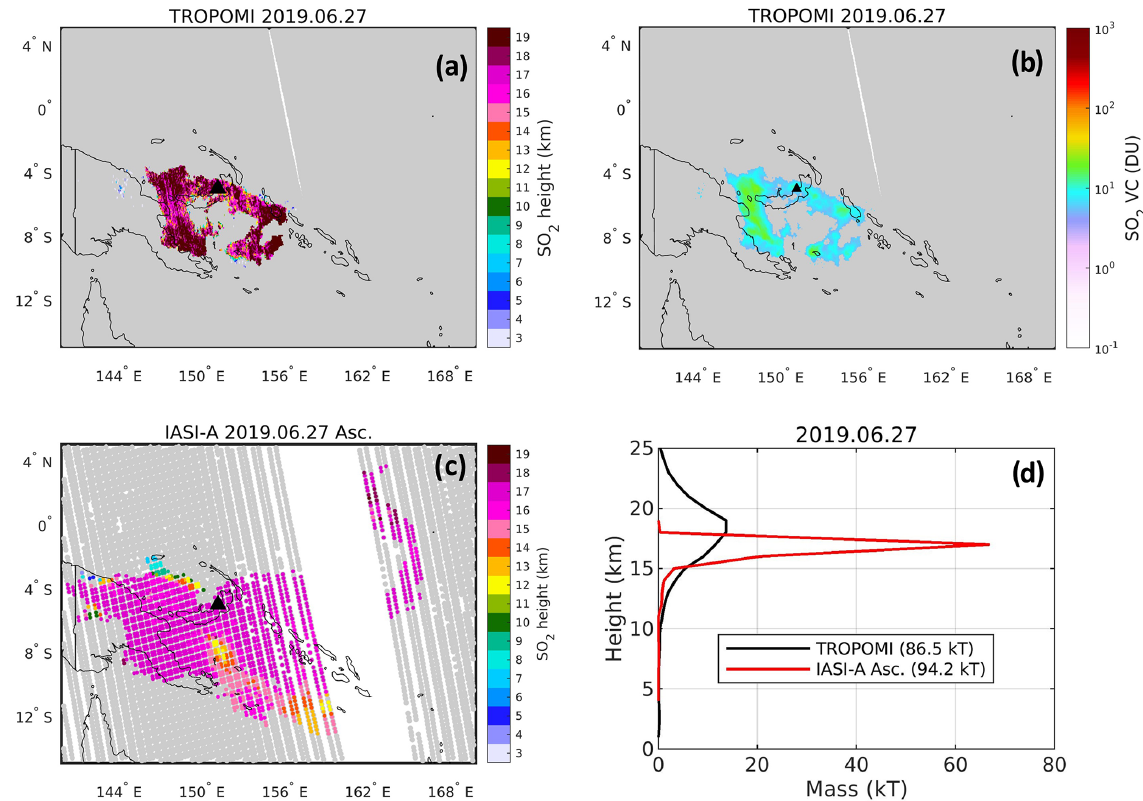
Figure 5. SO 2 plume on 27 June 2019 after the eruption of Ulawun. (a, b) TROPOMI retrievals of SO 2 LH and VCD, respectively; (c) SO 2 LH from IASI/MetOp-A (ascending orbit); (d) comparison of SO 2 mass histograms between TROPOMI and IASI. Total masses are indicated in the legend. The Ulawun volcano is marked by a black triangle. The gray pixels indicate the measurements with no SO 2 height